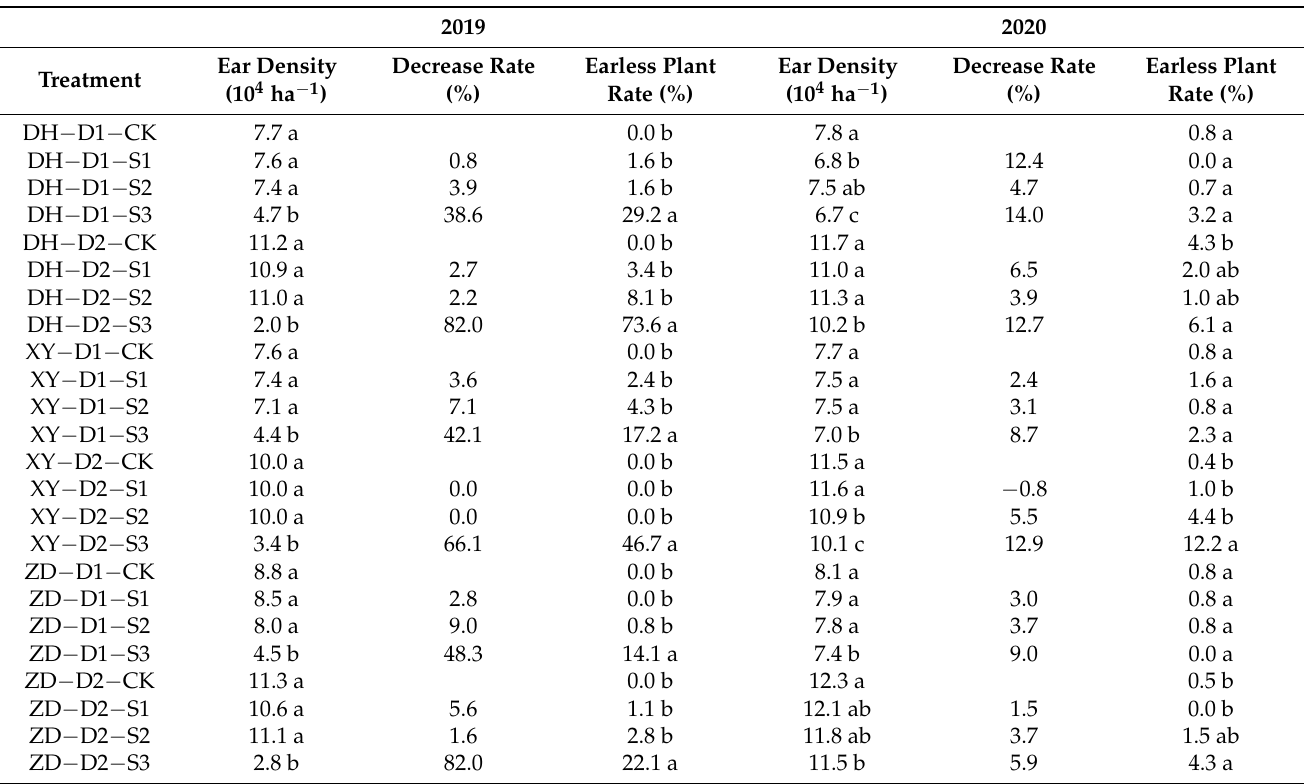
Table 1. Ear numbers, the rates of ear number decreases, and earless plant rates under different shading levels (CK: 100% natural light, S1: 85% natural light, S2: 70% natural light, S3: 50% natural light) and planting densities (D1: 7.5 × 10 4 plants ha − 1 , D2: 12 × 10 4 plants ha − 1 ) of three maize cultivars (Denghai 618 (DH), Xianyu 335 (XY), and Zhengdan 958 (ZD)) over two years. Means with different lowercase letters are significantly different at p <